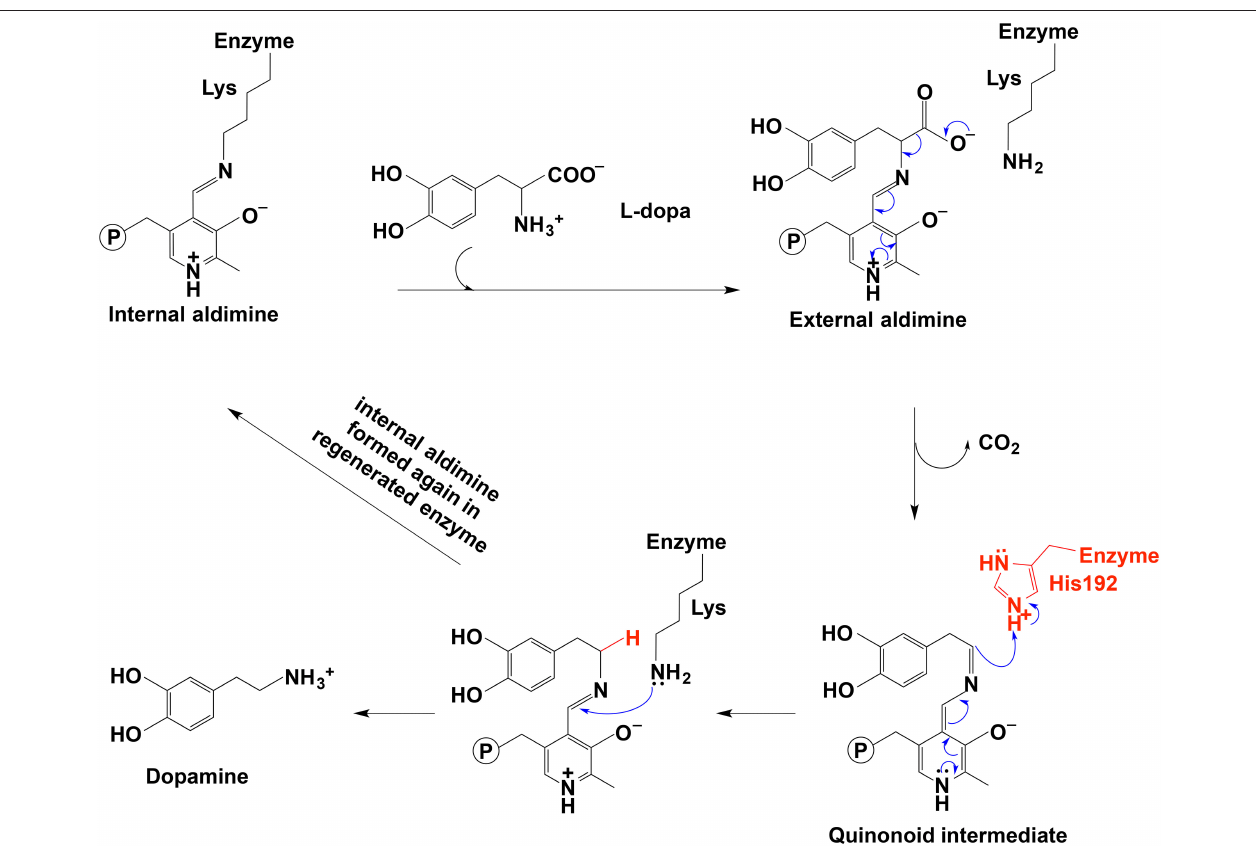
FIGURE 5 | The mechanistic role of His192 residue in typical decarboxylation is shown (Liang et al.,